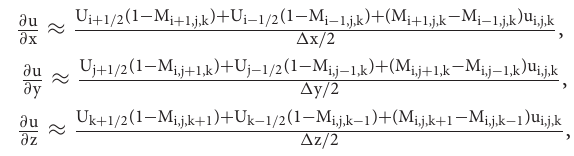
FIGURE 5 | Vessel center line ( E s) and radius ( E R ′ ) vectors. The vessel/aneurysm geometry is automatically segmented in the Cartesian ROI. The center line vector is defined by the vessel center points (red circle symbols) and the vessel radius vector is calculated from the in-plane radius vector ( E